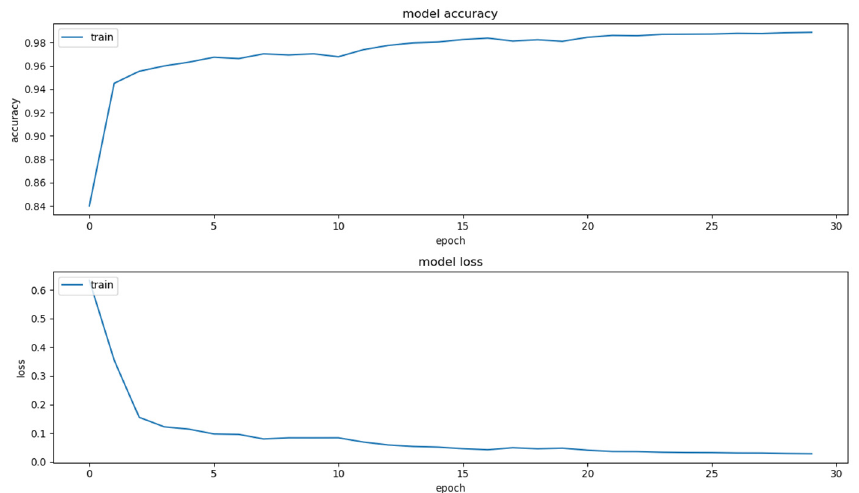
Figure 7. The training curve of the proposed information fusion based multi-source data segmenta- tion model.